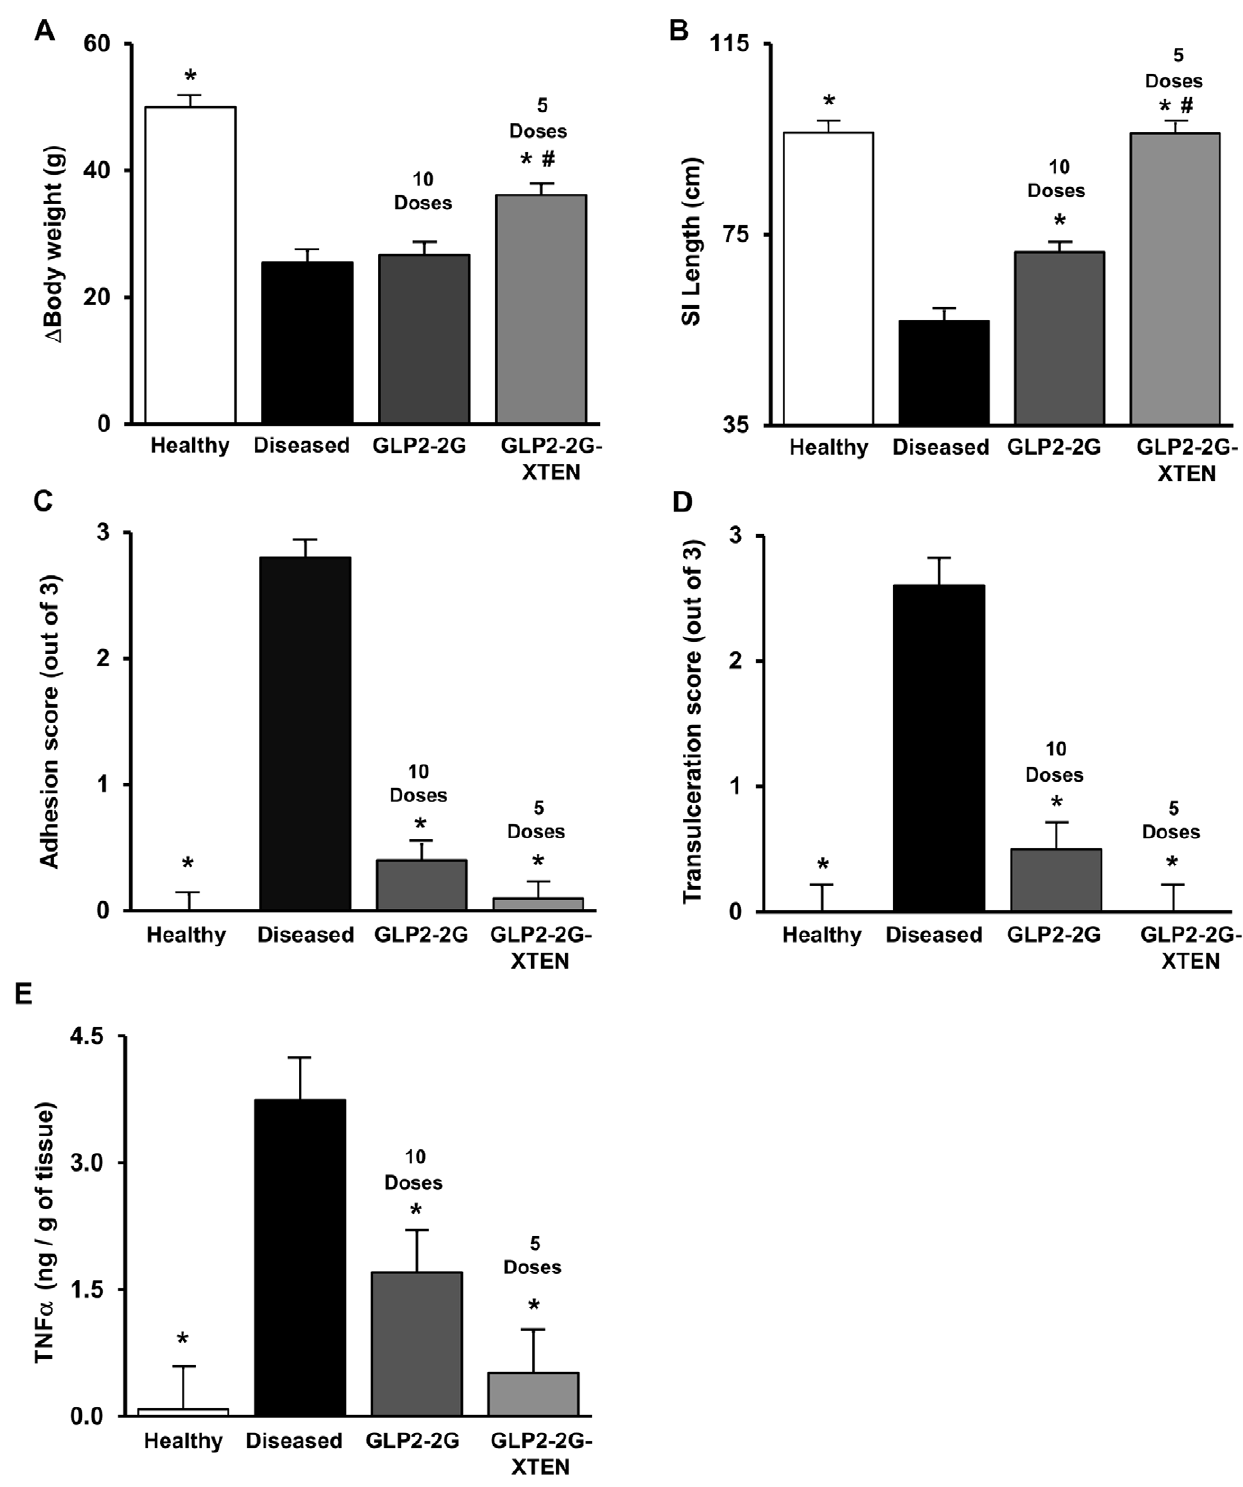
Figure 4. Efficacy of equal molar GLP2-2G-XTEN and GLP2-2G peptide in rat indomethacin-induced disease model. Data shown are A) change in body weight from day 2 3 through day 2, B) small intestine length, C) small intestine adhesion score, D) small intestine trans-ulceration score and E) small intestine TNF a concentration. Open bars are healthy rats treated with vehicle; colored bars are indomethacin-induced diseased rats treated with vehicle, GLP2-2G peptide (12.5 nmol/kg per injection; twice per day for 5 days) or GLP2-2G-XTEN (25 nmol/kg once per day for 5 days) as indicated. Compounds were dosed starting three days prior to first indomethacin injection (Day 2 3) and data shown are from the time of sacrifice on Day 2 (24 hours post second indomethacin injection). Data are means and SE, n=10 per group. * P , 0.05 compared to diseased, vehicle-treated rats, # P , 0.05 compared to diseased GLP2-2G peptide treated rats.